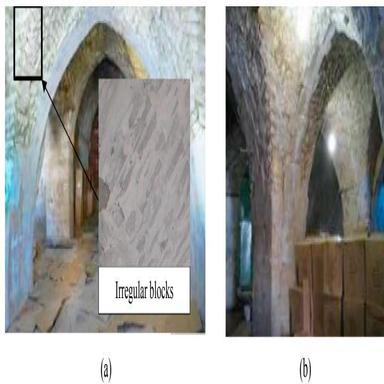
The existing groin vaults in St John Hospital. Details of the vaulted structures (a) and of the lateral arches (b).